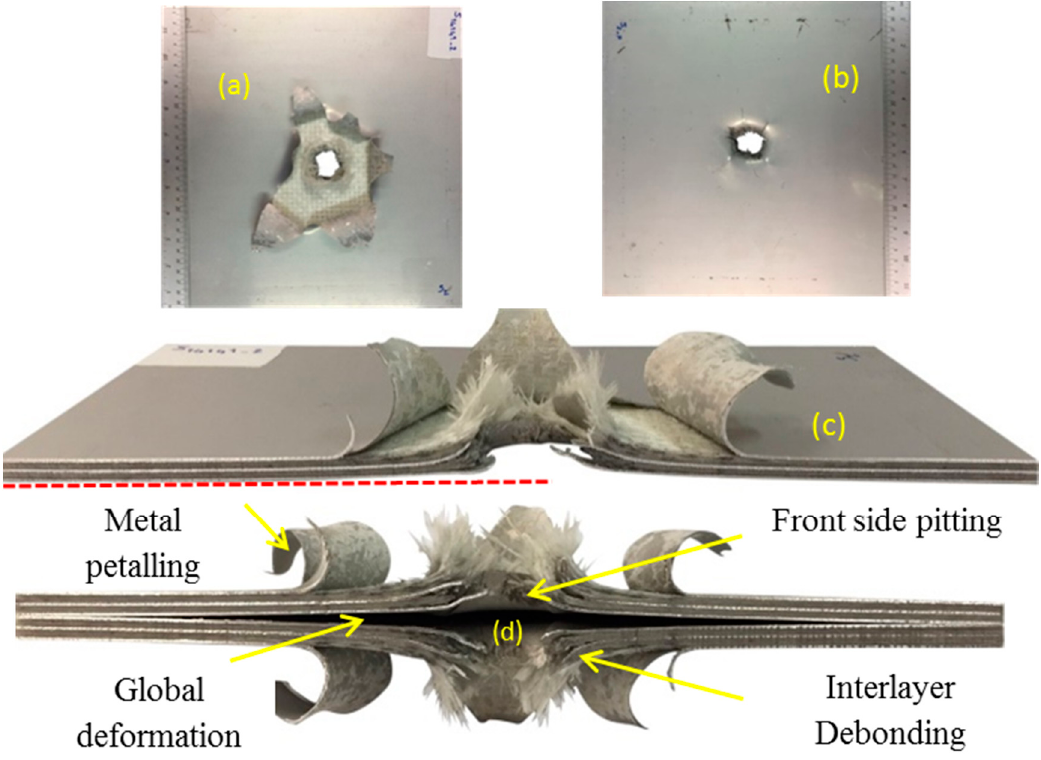
Figure 6. Sample code S14141-2 in impulse 12.5 N.s ( a ) rear face, ( b ) front face, ( c ) cross section, ( d ) double side cross section.